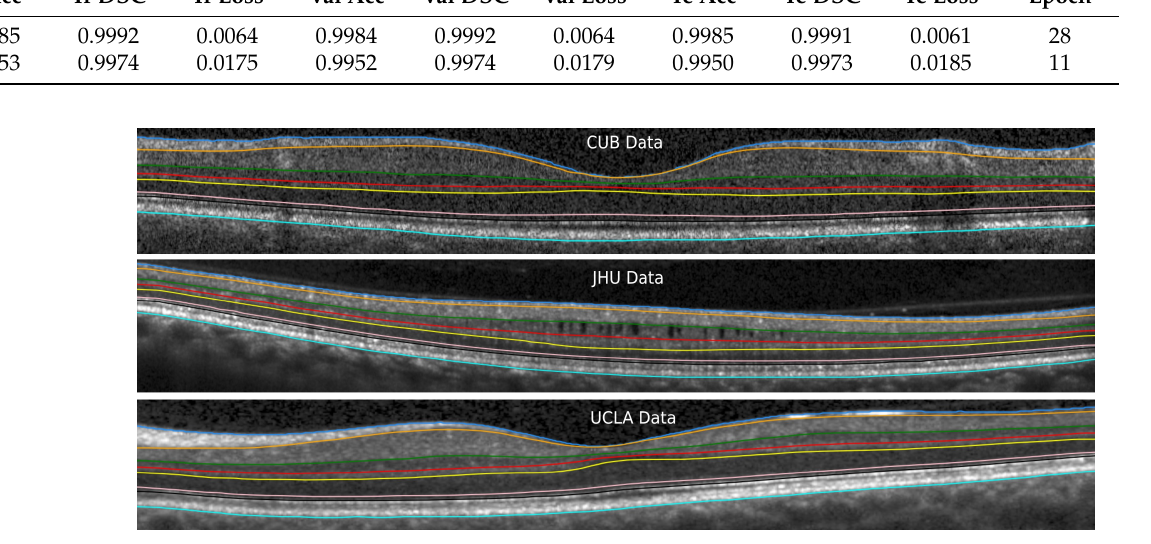
Figure 6. The visualization of the segmentation lines computed by the proposed method for three different data sets.